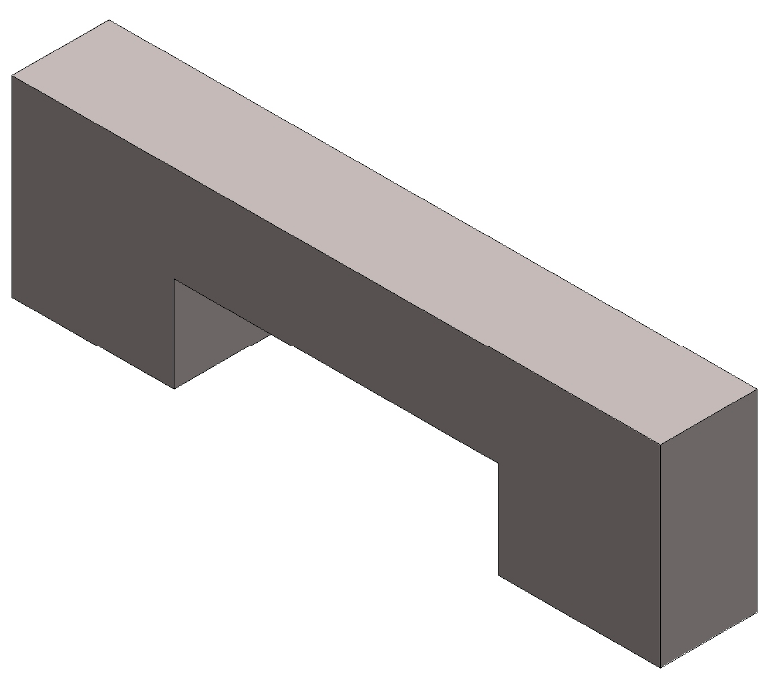
Figure 7. CAD design of the micro beam. The support structures under the micro beam are removed.